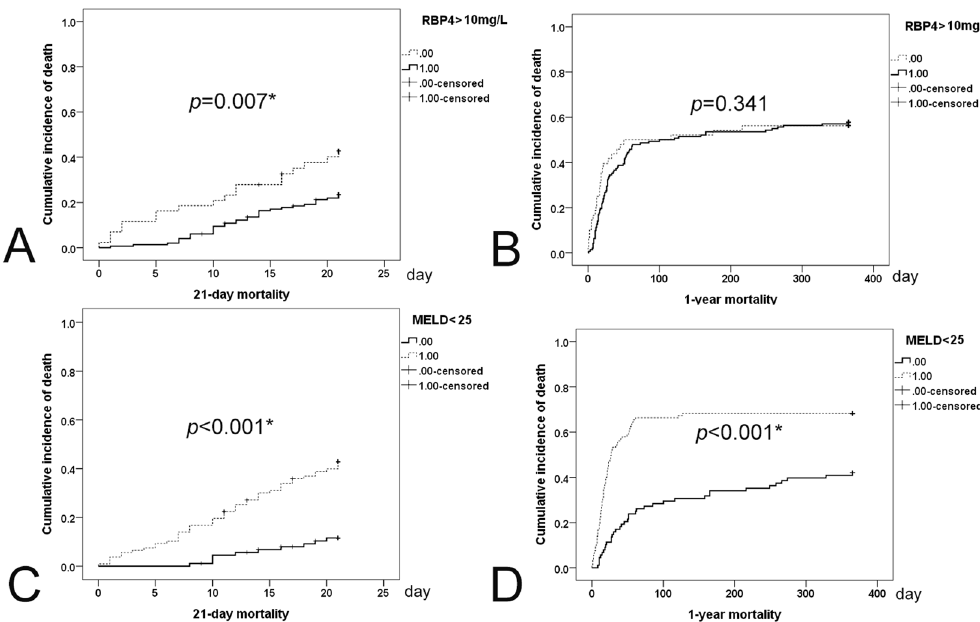
Figure 3. Cumulative incidence of death curves. ( A ) and ( C ), 21-day cumulative incidence of death; ( B ) and ( D ), 1-year cumulative incidence of death. ( A ) and ( B ), dashed lines, baseline RBP4 levels < or = 10 mg/L; solid lines, baseline RBP4 levels > 10 mg/L. ( C ) and ( D ), dashed lines, baseline MELD scores > or = 25; solid lines, baseline MELD scores < 25. * p <